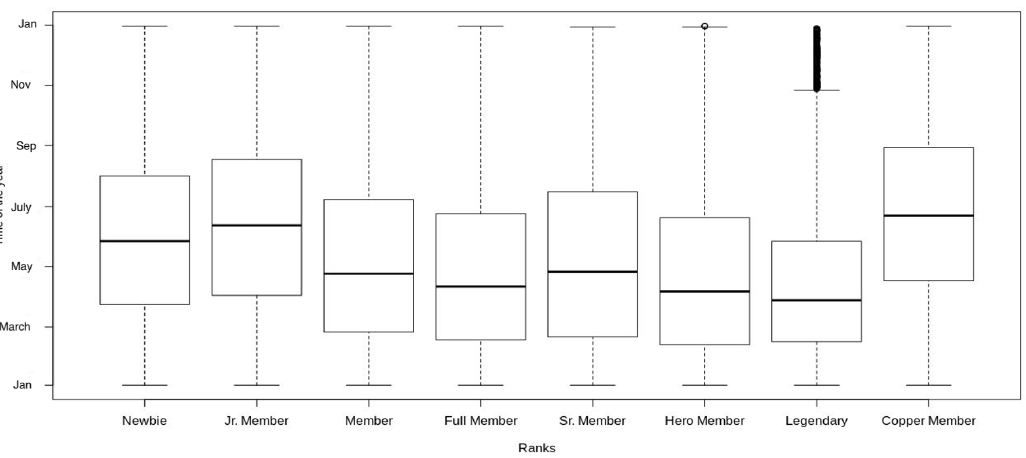
Figure 6. Posts by time of the year and